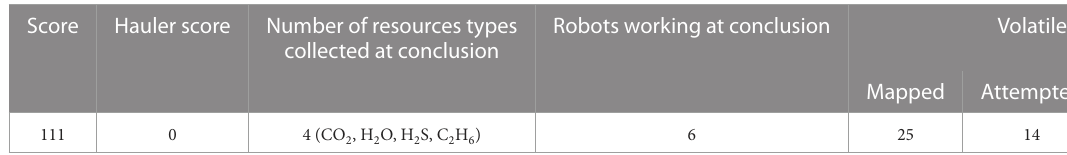
TABLE1 Samplerunmetrics.